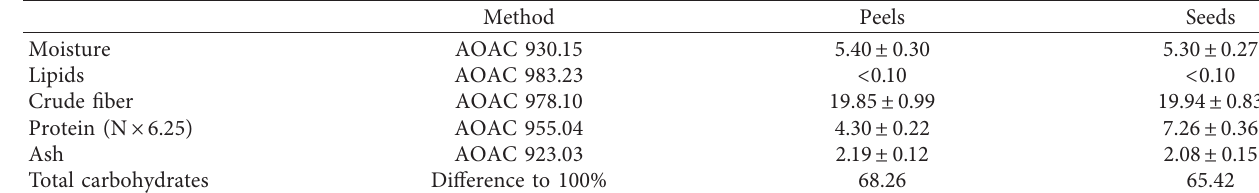
Table 1: Proximal composition of nance peels and seeds (% wb) ∗ .